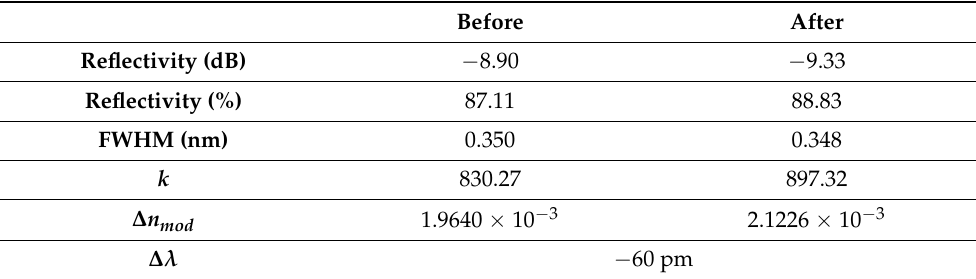
Table 2. Spectral characteristics of the PlbPl -FBG before and after exposure to γ -radiation. Before After